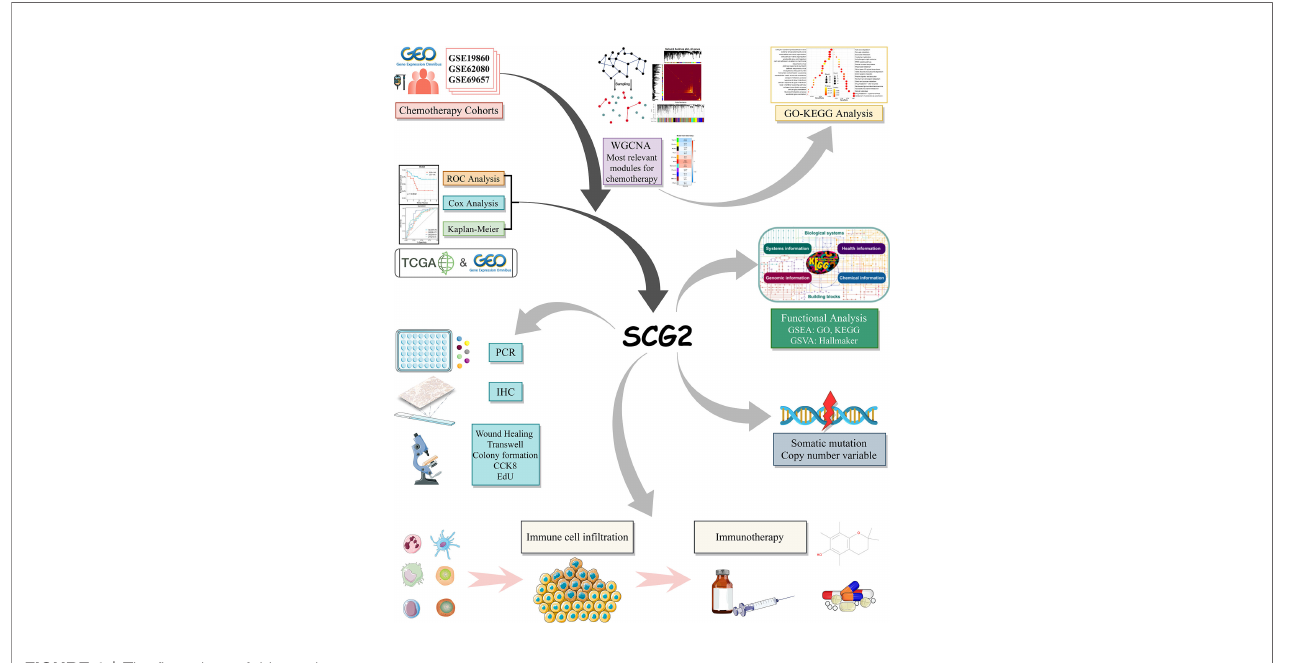
FIGURE 1 | The fl ow chart of this